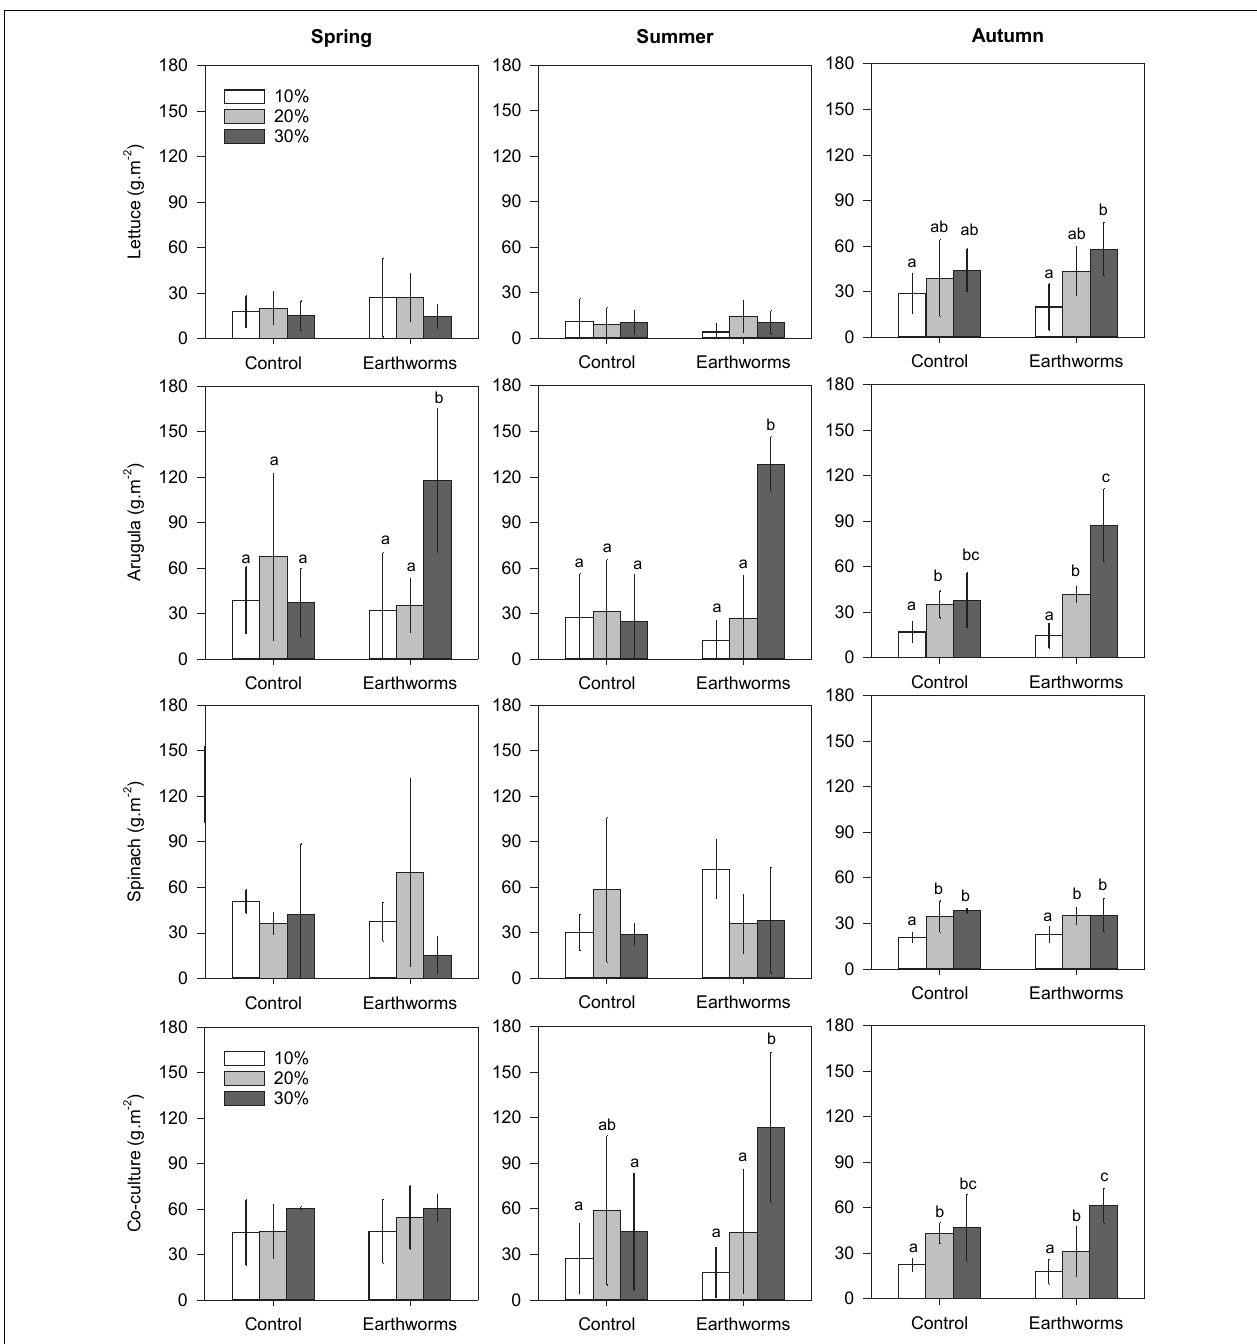
FIGURE 1 | Shoot biomass (dry weight per m 2 ) of lettuce, arugula, spinach in monoculture and co-culture obtained at each season (spring, summer, and autumn) as function of earthworms presence for the three Technosols composition. The error bars are the standard errors of the mean ( n = 4). Different letters above the histogram indicate significant differences ( P < 0.05) between